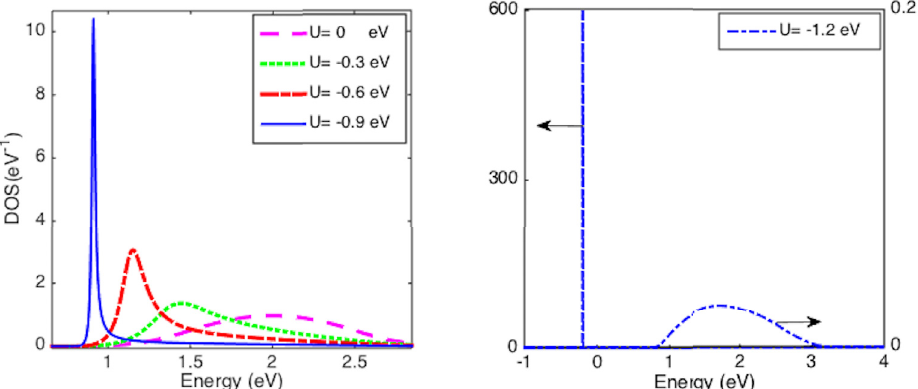
Fig. 5. LDOS as a function of the energy of the absorbed photon under the influence of short-range electron-hole interaction. fluxes. Technically, one can compute | Ψ p ( E ) (cid:2) based on the product of recursion